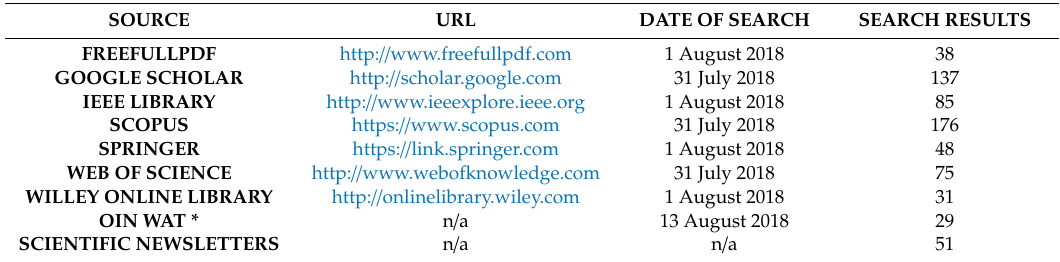
Table 1. Electronic databases used during the review process (source: own study). SOURCE